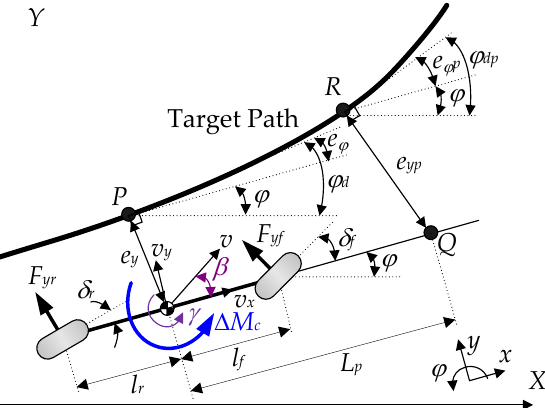
Figure 3. Coordinates and variables of 2-DOF dynamic bicycle model used for path tracking.